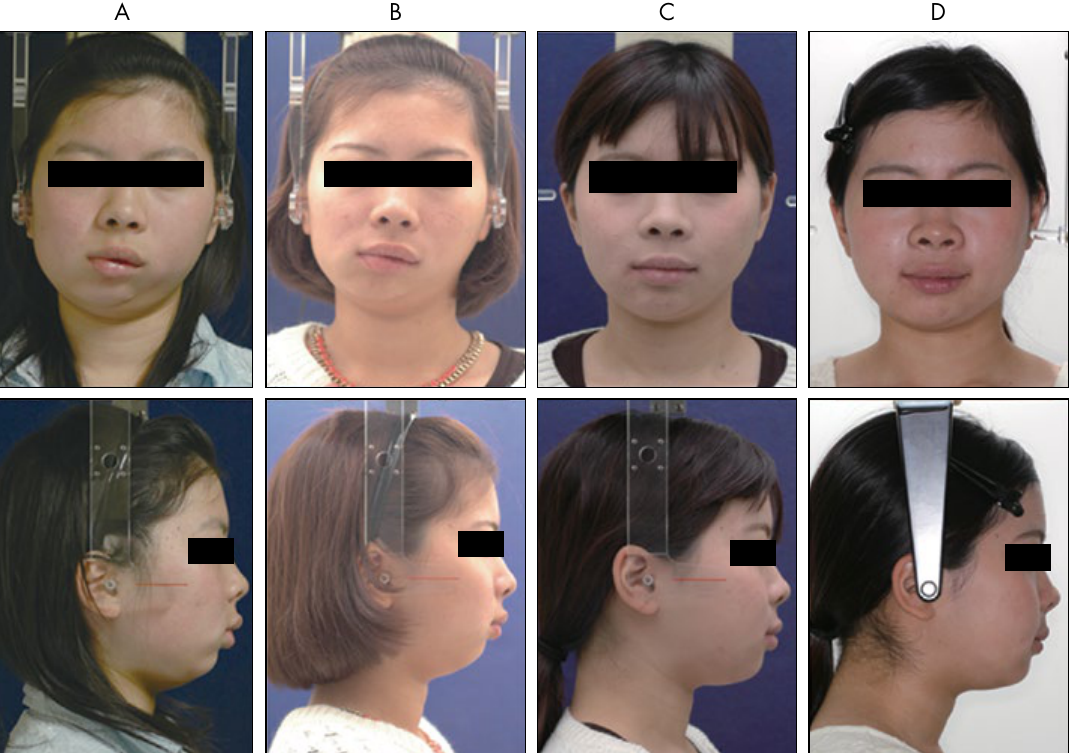
Figure 1. Facial photographs. A: pretreatment; B: pre-surgery; C: post-treatment; D: post-retention, two years and six months after